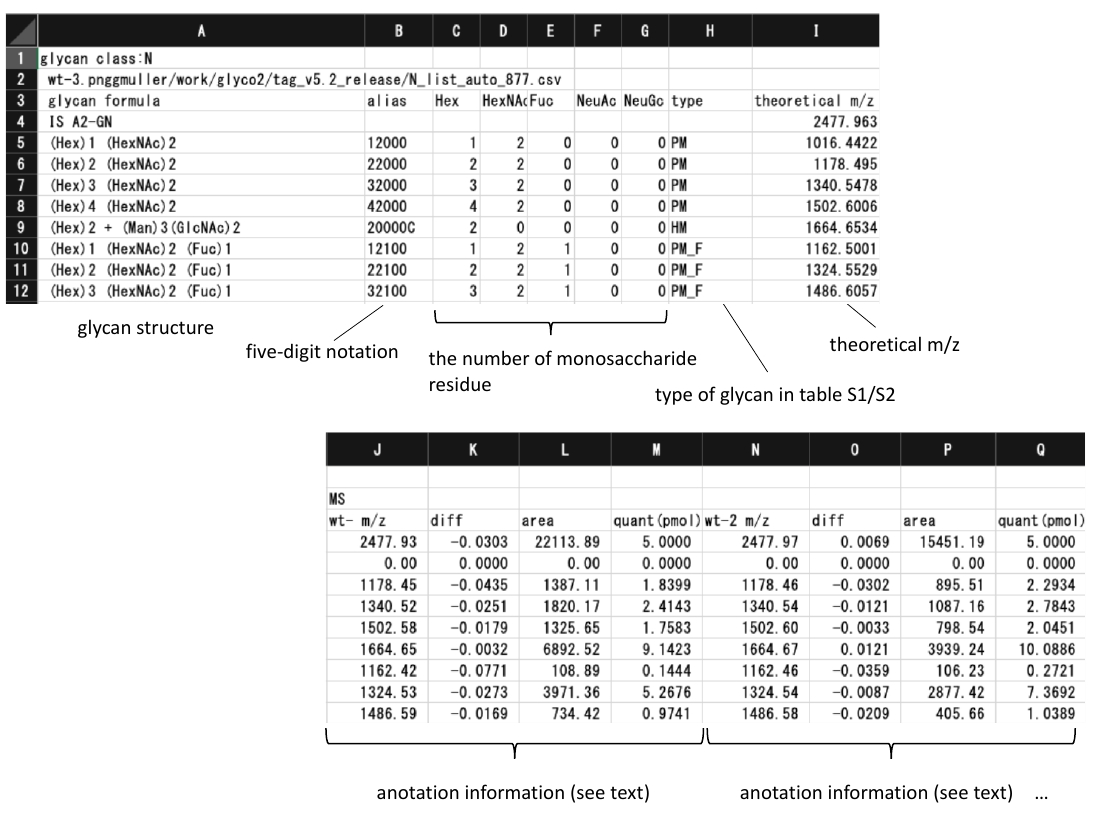
Figure 6. Part of the ‘out_list.csv’ output file for glycan annotation by TAG